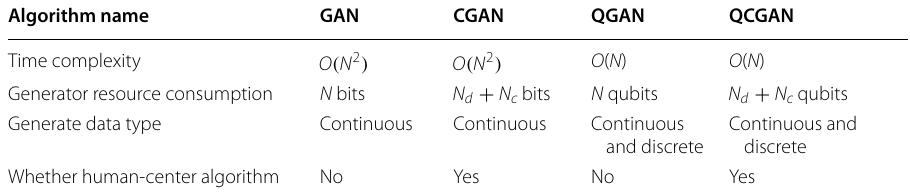
Table 1 Performance comparison of 4 generative adversarial network